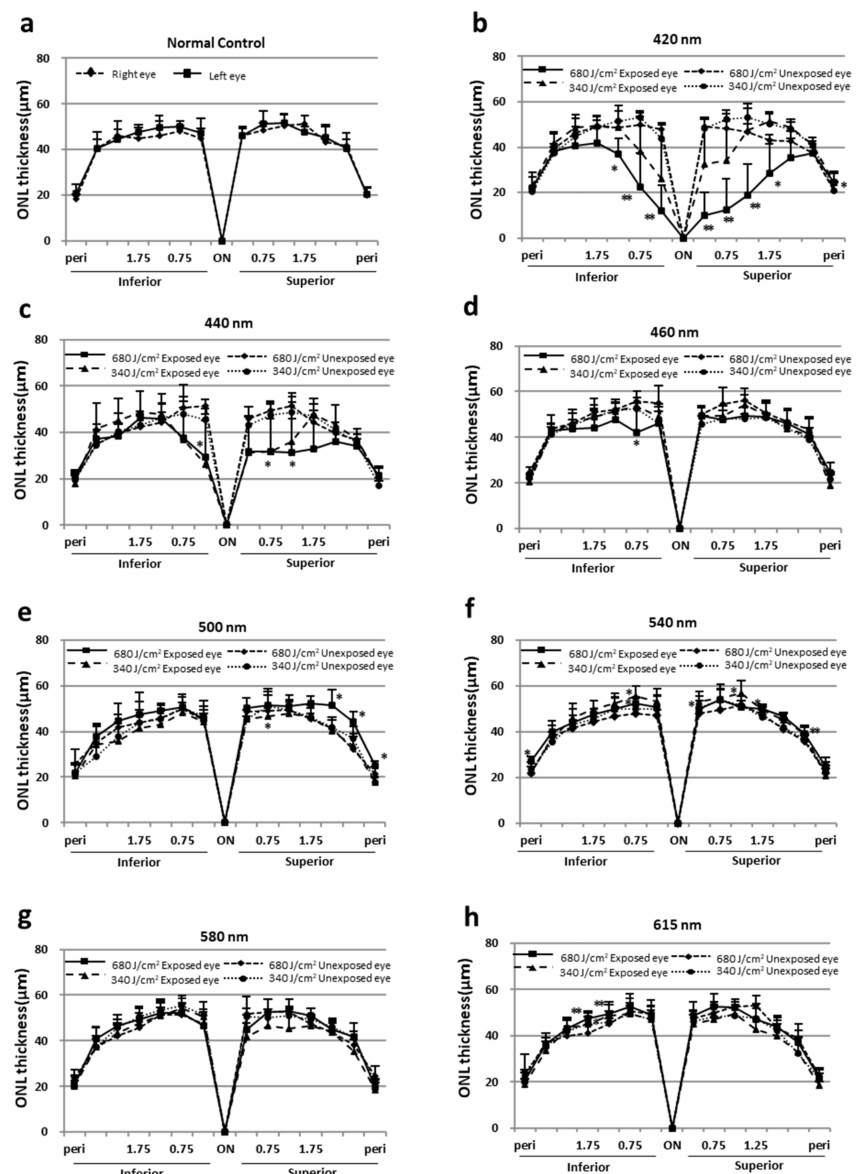
Figure 2. ONL thicknesses in normal controls and those exposed to light. ( a ) ONL thickness of normal control retinas. ( b – h ) ONL thicknesses of light-exposed retinas (left eye) are compared with those of unexposed retinas (right eye) at the following wavelengths: 420 nm, 440 nm, 460 nm, 500 nm, 540 nm, 580 nm, and 615 nm. The data are expressed as the mean ± SD ( n = 6 in each group). Comparisons between groups were performed using the unpaired t -test. * p < 0.05 and ** p < 0.01 vs. unexposed